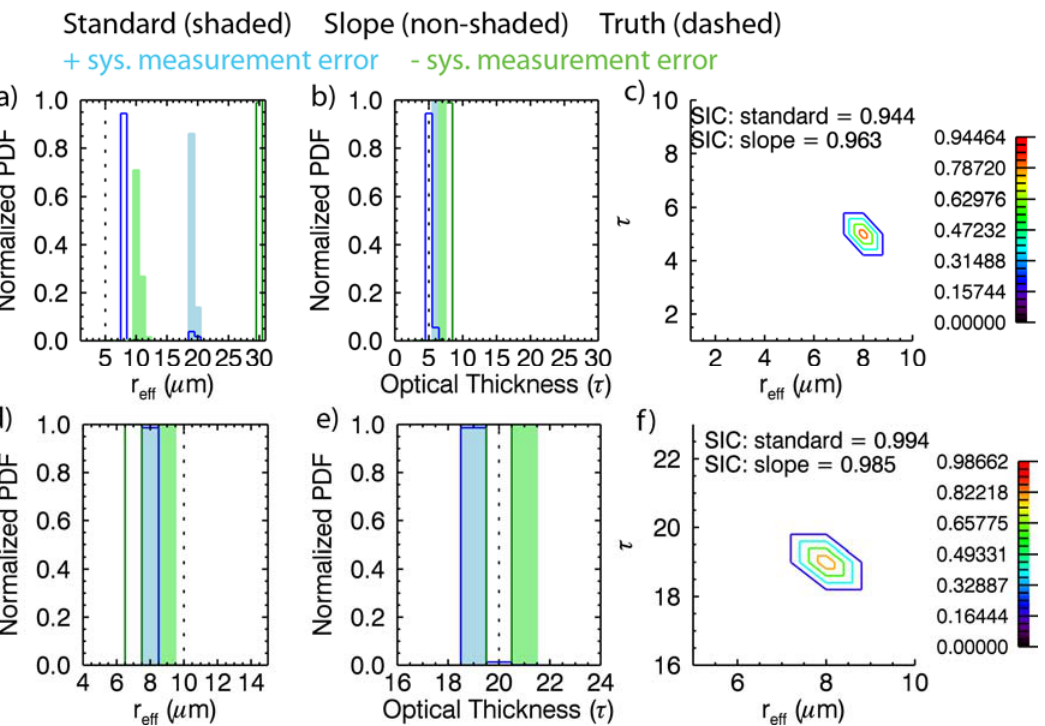
Figure 6. Marginal pdfs in effective radius (r , in μ m) and optical thickness and the joint eff = 5, 5 μ m and for ( d–f ) true τ , r = 20, 10 μ m. Marginal pdf posterior pdf for ( a–c ) true τ , r e e results are shown for standard (shaded histograms) and slope (non-shaded histograms) methods; the spread in the histograms results from ±3% systematic measurement errors (‘+’ in blue; ‘ − ’ in green) and ±30% uncertainty in water vapor. True values in τ and r are e indicated with vertical dashed lines. The joint posterior pdf (for the slope method) is shown with colored contours and the highest contour level is centered on the maximum likelihood solution. Shifts in the maximum likelihood solution from the true values represent retrieval biases. The normalized Shannon Information Content (SIC) in the joint posterior pdf for standard and slope methods is indicated on ( c ) and ( f ). Calculations shown are for μ = 0